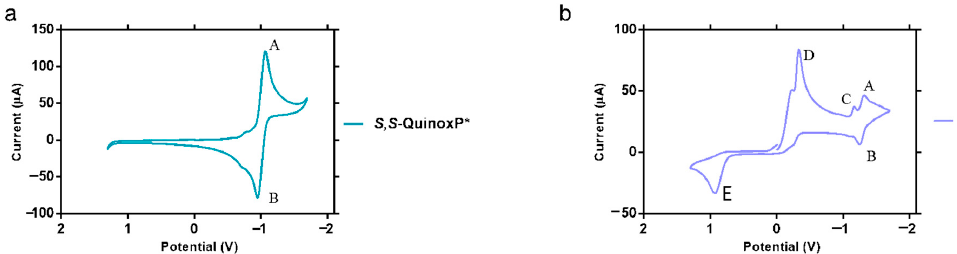
Figure 6. Cyclic voltammograms of ( a ) S , S -QuinoxP* ligand and ( b ) complex 2 . This experiment was performed at room temperature in acetonitrile solution with 0.10 M NBu 4 PF 6 electrolyte at 100 mV/s scan rate. The potential is referenced to Ag/AgCl.